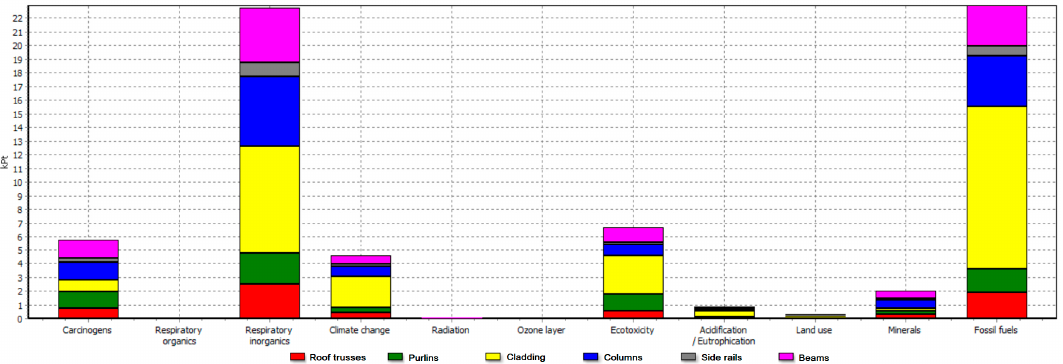
Figure 5. Weighting comparison of the environmental impact categories related to the main parts of the steelwork.